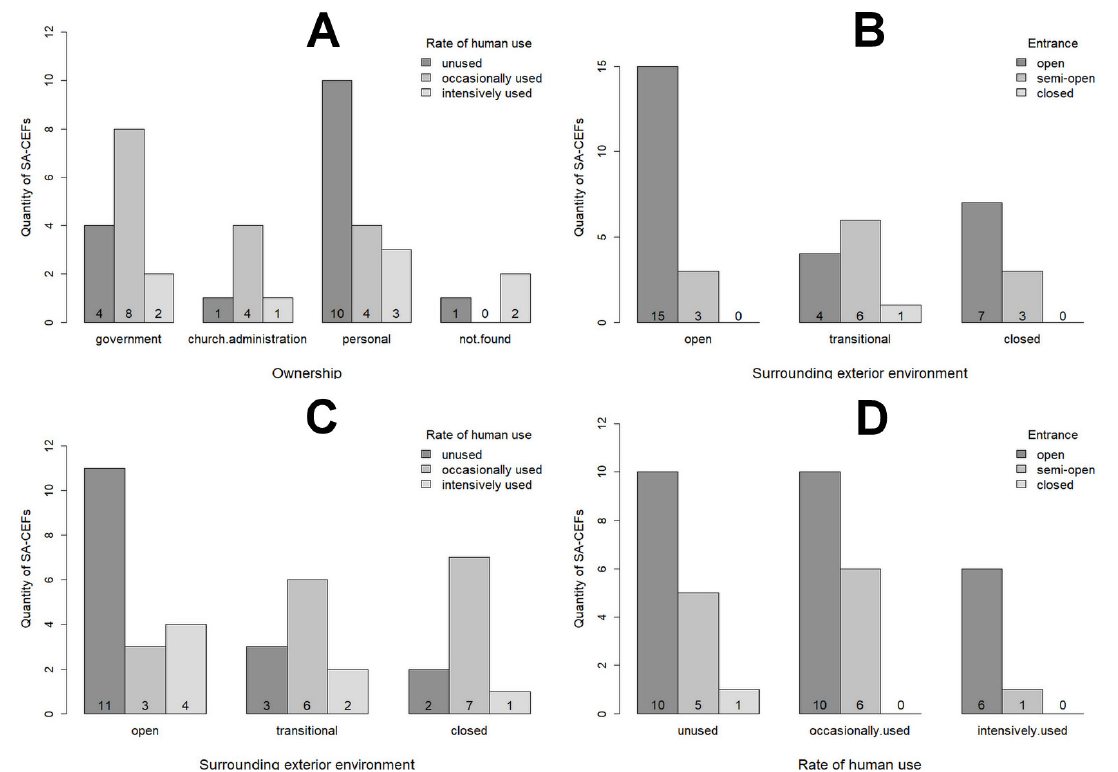
Figure 8. ( A )—Relation between ‘Ownership of SA-CEFs’ and ‘Rate of human use of indoor environ- ment in SA-CEFs’. ( B )—Relation between ‘Type of surrounding exterior environment of SA-CEFs’ and ‘Entrance accessibility in SA-CEFs’. ( C )—Relation between ‘Type of surrounding exterior environ- ment of SA-CEFs’ and ‘Rate of human use of indoor environment in SA-CEFs’. ( D )—Relation between ‘Rate of human use of indoor environment in SA-CEFs’ and ‘Entrance accessibility in